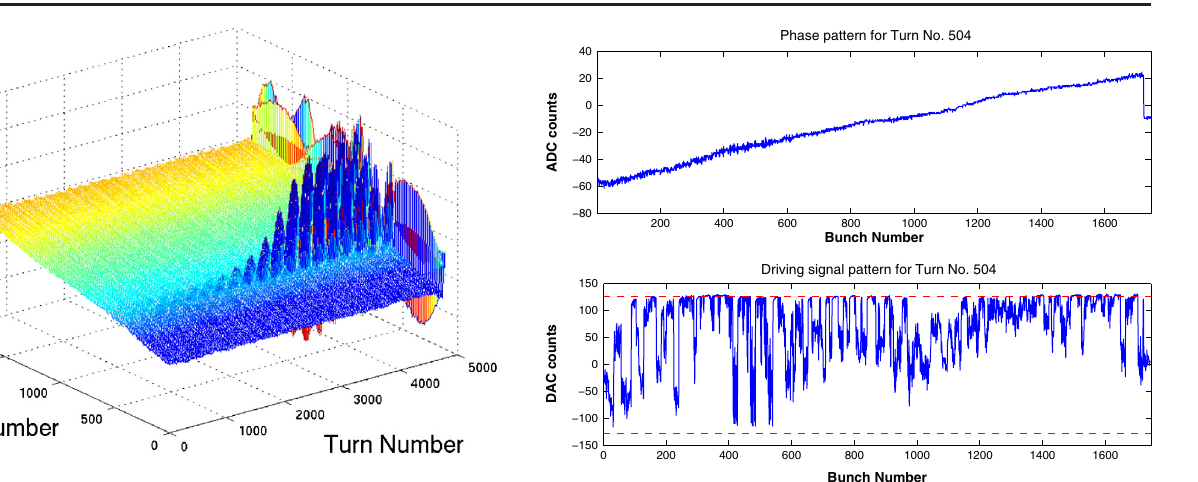
FIG. 9. (Color) Time-domain fault file from the HER showing the data at the input of the DSP filters. The individual bunch coordinates are shown during the same interval as Fig. 8. At roughly 1000 turns in the data set impulsive rf power supply noise (or phase reference noise), with amplitudes of a few A/D counts, becomes problematic as a barycentric motion (mode zero) gets excited at an amplitude which saturates the broadband feedback channel.